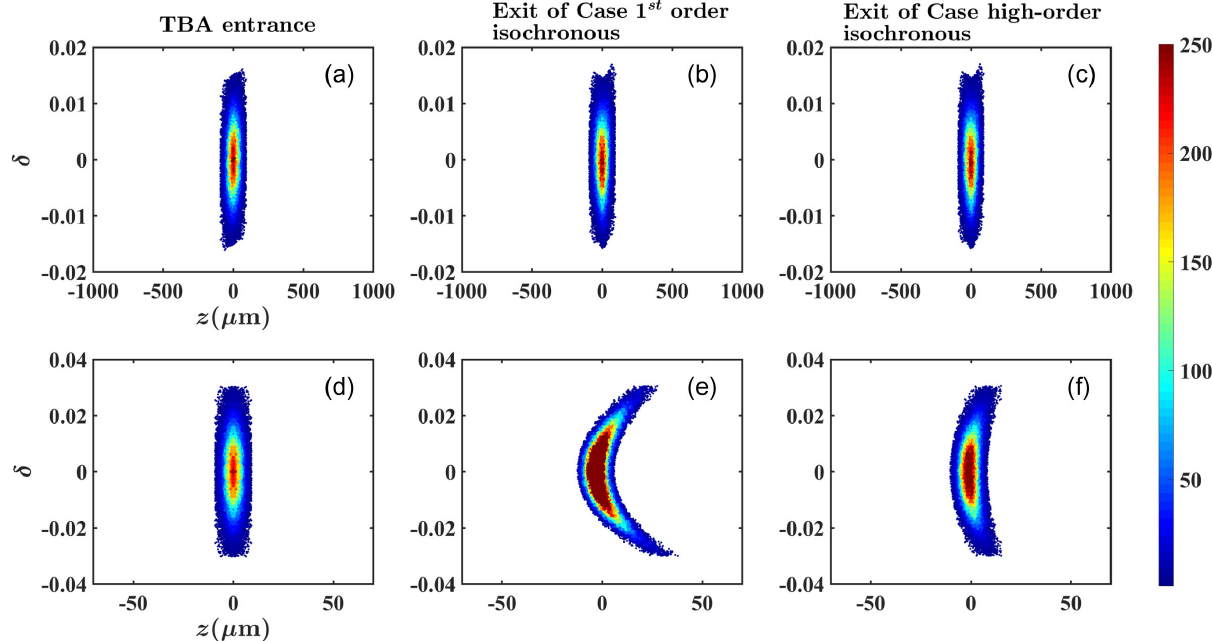
FIG. 8. Longitudinal phase space distribution of the bunch at the entrance of the TBA (left), the exit of Case 1st order isochronous (middle), and Case high-order isochronous (right), using conventional rf beam parameters [top row, (a), (b) and (c)] and LPA beam parameters [bottom row, (d), (e) and (f)]. The colorbar shows the particle